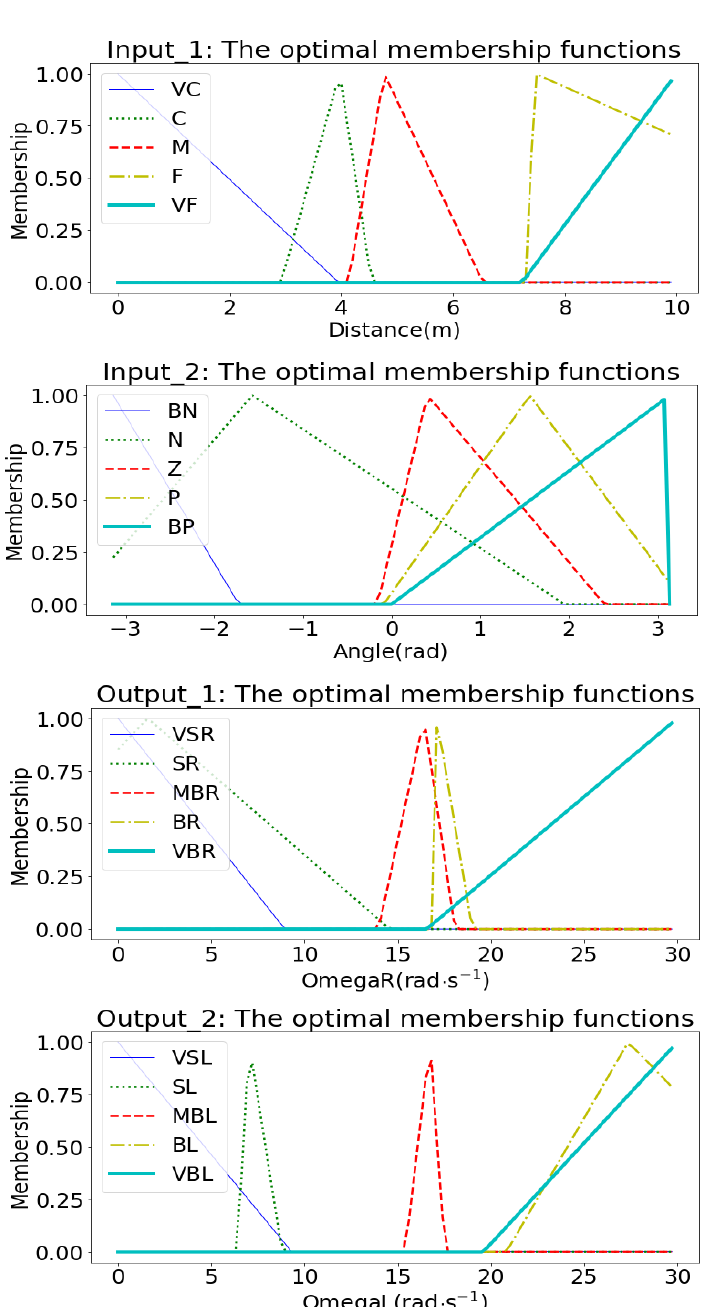
Figure 14. The suboptimal membership functions.